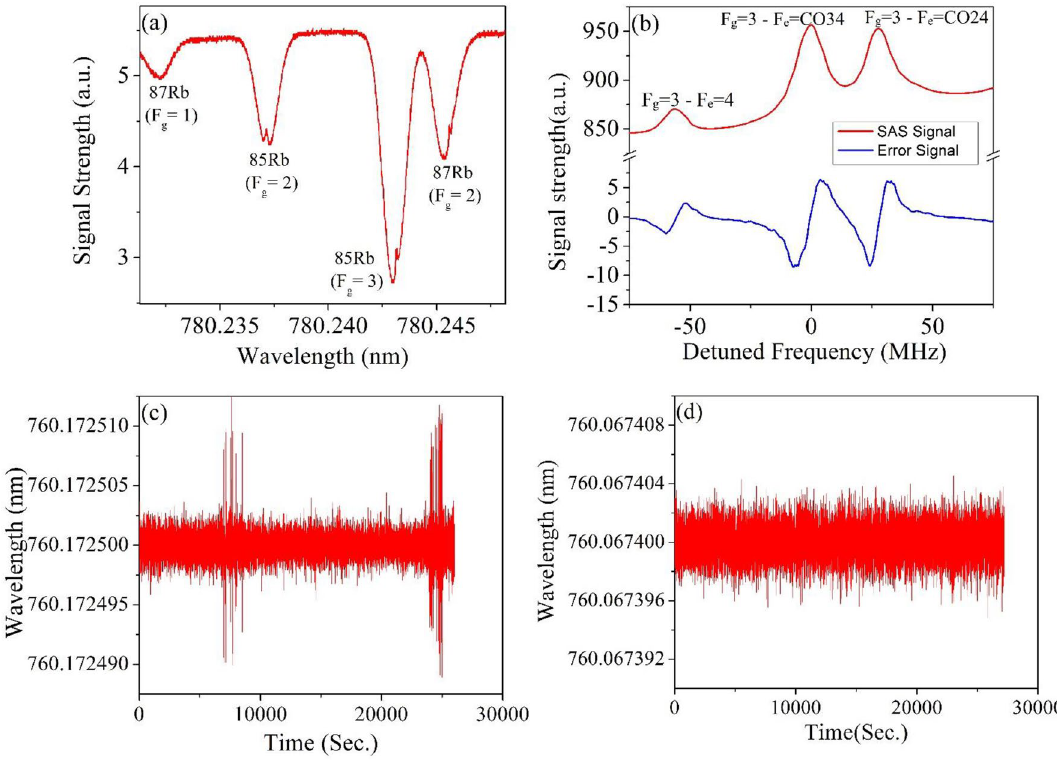
Figure 2. ( a ) Doppler broadening free saturated absorption spectra (SAS) for D 2 transition of 87 Rb and 85 Rb atoms (y-axis-signal strength (a.u.). ( b ) Doppler broadening free SAS peaks (red line) for hyperfine transitions F g = 3 to F e = 4, F g = 3 to F e = CO34 (Crossover peak of F e = 3 and F e = 4) and F g = 3 to F e = CO24 (Crossover peak of F e = 2 and F e = 4) of 85 Rb and their first order derivative as error signal (blue), the peak corresponding F g = 3 to F e = CO34 transition (υ = 384.229149 THz) has been used as the reference signal for calibrating and locking the wavelength meter. ( c ) Wavelength variation of a frequency stabilized laser, while the wavelength meter uses inbuilt Neon lamp as the reference of calibration. ( d ) Wavelength variation of a frequency stabilized laser, while the wavelength meter is calibrated to the SAS peak of 85 will be shifted due to Doppler Effect and the Doppler shift depends on the relative velocity of those atoms with respect to the laser beams, can be expressed as v x ν = ν 0 1 ± (cid:31) c (cid:30) where ν 0 is the resonance frequency for the atoms are in rest, i.e., atoms have no velocity component along the propagation direction of the laser beams, c is the velocity of light, and ν is the Doppler-shifted resonance fre- quency. In order to minimize the Doppler broadening of absorption spectra, saturated absorption spectroscopy (SAS) technique is used where counter-propagating high intense laser beam, named as pump beam and low intense probe beam passes through the vapour cell in counter propagating configuration. The linewidth of these saturated absorption spectra is much narrower than the Doppler broaden absorption spectra. Width of the Doppler broadening free absorption spectra, i.e., saturated absorption spectra, depends on the natural linewidth of that atomic transition. Width of the SAS spectra also depends on the power of the incident laser beam and broadened linearly with the increase of laser power. Hence, the linewidth of the SAS spectra can also be opti- mized by reducing the power of the laser beam. Usually Doppler broaden absorption spectra have linewidth of hundreds of MHz but for SAS spectra linewidths are achieved within tens of MHz. Thus, output of any laser can be stabilized or locked to the peak of a reference SAS signal. In the present study Rb vapour cell has been chosen for generating SAS signal as Rb exists in vapour state at room temperature and no additional heating is required. In addition, atomic Rb provides many closely spaced transition frequency in the optical domain and eventually provide multiple number of Doppler broadening free SAS 23,29–31 transitions frequencies over a wide wavelength range. Natural Rb atoms have two isotopes with relative abundance of 72% for 85 Rb and 28% for 87 Rb. In the present experimental setup, the D 2 hyperfine transitions (5S 1/2 –5P 3/2 ) of Rb atoms at ~ 780 nm have been probed for obtaining Doppler broadening free SAS peaks. Figure 2a depicts the absorption spectra with the SAS peaks for 87 Rb (F 85 Rb (F 85 Rb which have hyperfine transitions F g = 1, 2) and g = 2, 3). In our experiment we are using g = 3 to F e = 4, F g = 3 to F e = CO34 (Crossover peak of F e = 3 and F e = 4) and F g = 3 to F e = CO24 (Crossover peak of F e = 2 and F e = 4) with corresponding linewidths of 13.73 MHz, 20.75 MHz and 21.83 MHz respectively. Our measured linewidths as mentioned in Table 1 are in good agreement with earlier measured and reported values 29,32 . One